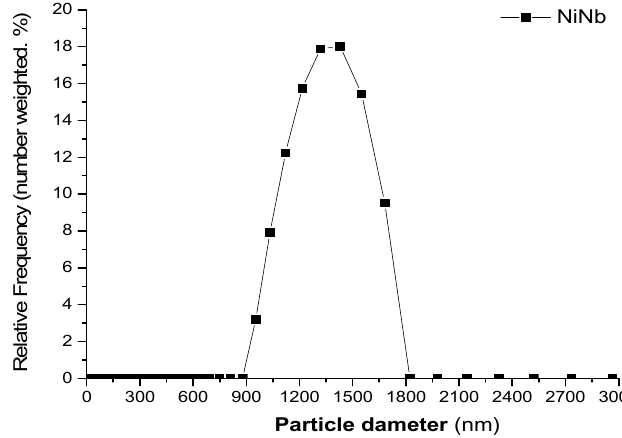
Figure 3. Particle size distribution and surface charge.